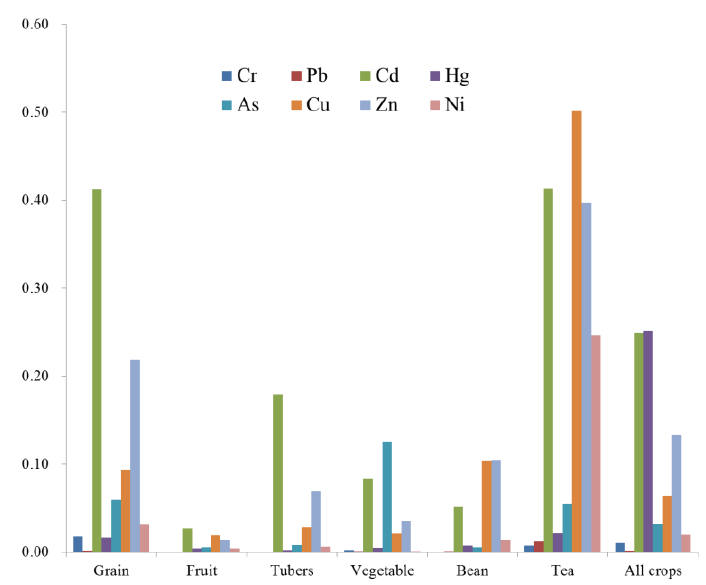
Figure 7. The bioaccumulation factors (BAFs) of heavy metals in different crops.